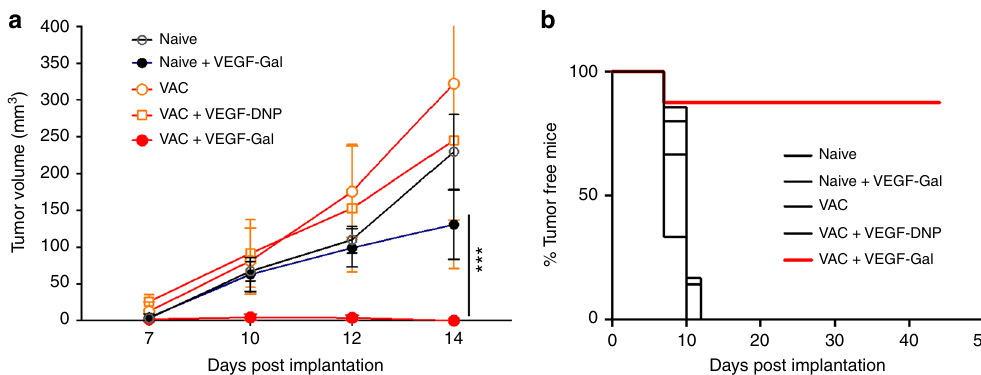
Fig. 6 Targeting α Gal trisaccharide to tumor cells. α Gal-null (C57BL/6xDBA/2Jx129sv GT − / − ) mice were vaccinated with pig kidney extracts to boost the titer of anti- α Gal antibodies and 10 day later challenged subcutaneously with 5 × 10 5 α Gal low/negative B16BL6 tumor cells. 3 days post tumor implantation mice were treated with VEGF – DNP or VEGF – α Gal hapten conjugates and tumor growth was measured. a Tumor volume. Statistical analysis: VEGF – α Gal in VAC versus naive, *** p = 0.0037, Student ’ s t -test. b Time to tumor appearance. Statistical analysis: VEGF- α Gal in VAC versus naive or any other group, p < 0.0001, Log-rank test for signi fi cance. (7 mice per group) ( n = 2). Data are represented as mean ±